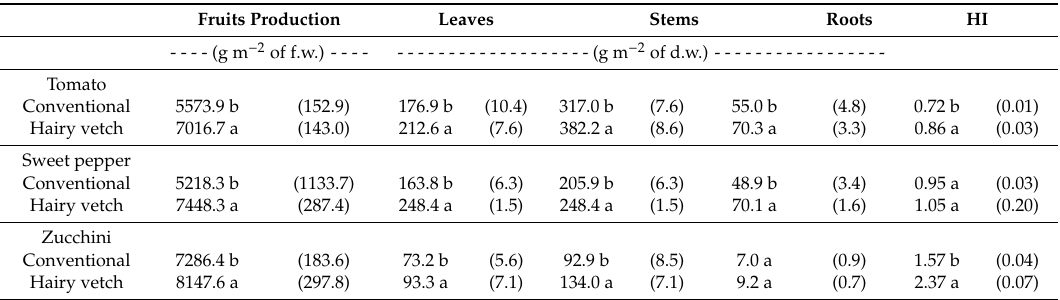
Table 3. E ff ect of hairy vetch mulching on fruit yield, leaves, stems, roots and harvest index (HI) of the summer vegetable